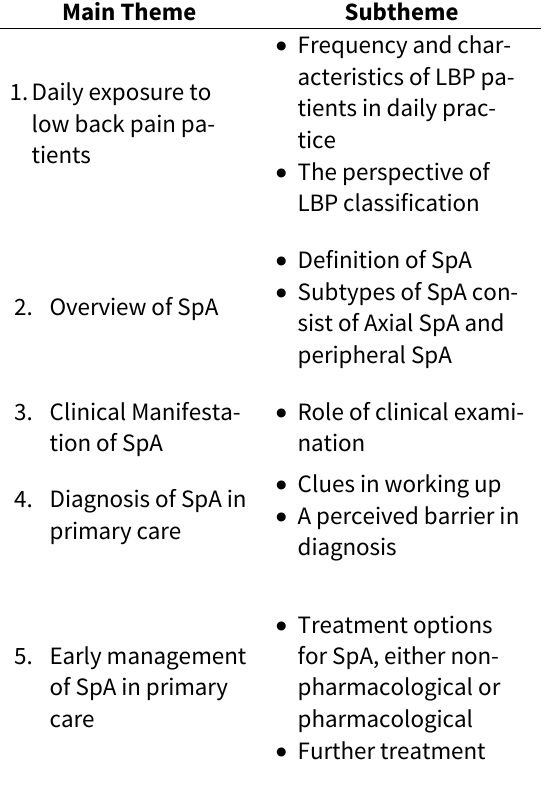
Table 1 . Developed Main Themes and Subthemes